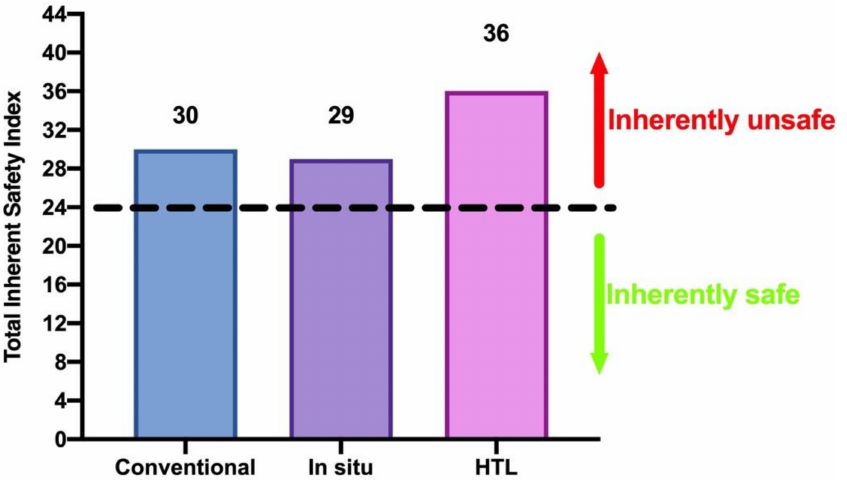
Figure 7. Total inherent safety index for three topologies for biodiesel production from